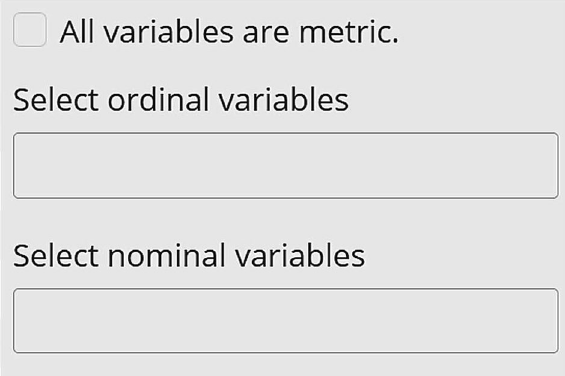
Fig. 2 Setting of scale level in the background data